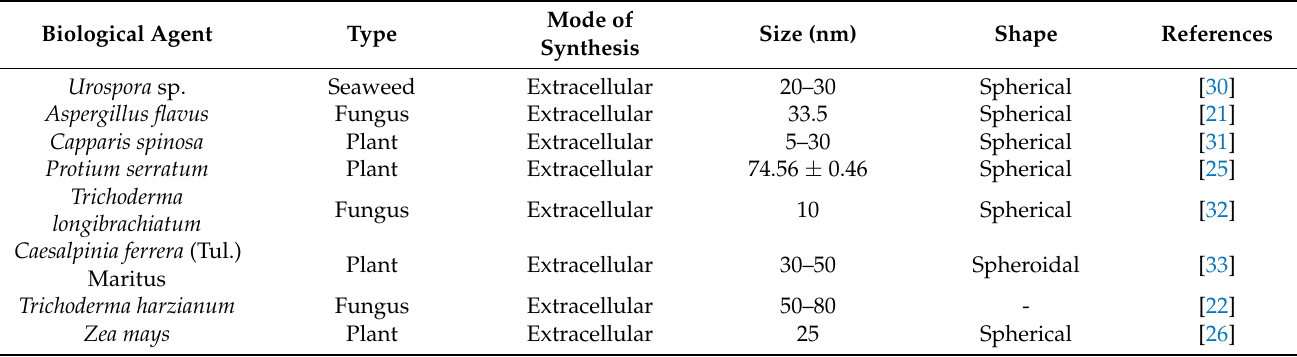
Figure 3. TEM micrographs of bio-AgNPs from ( A ) actinobacterial strain SF23 (adapted from [9], open access article), ( B ) myxobacteria, ( C ) Fusarium oxysporum , ( D ) Fusarium tricinctum , and ( E ) Urtica dioica . Table 2. List of biological agents used for the synthesis of AgNPs.